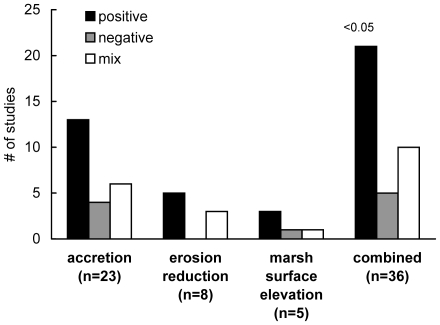
Reported outcomes from all shoreline stabilization publications comparing accretion, erosion reduction, or marsh surface elevation change in both vegetated and unvegetated salt marsh areas.The numbers of outcomes associated with each trend are plotted for each measure of shoreline stabilization and also all measures combined: gray bars represent a negative effect on the process, white bars represent no effect or mixed results and black bars represent a positive effect on the process. P value above the combined bars is significance value for chi square test. P values not reported for individual measures of effect due to insufficient frequency cell counts.